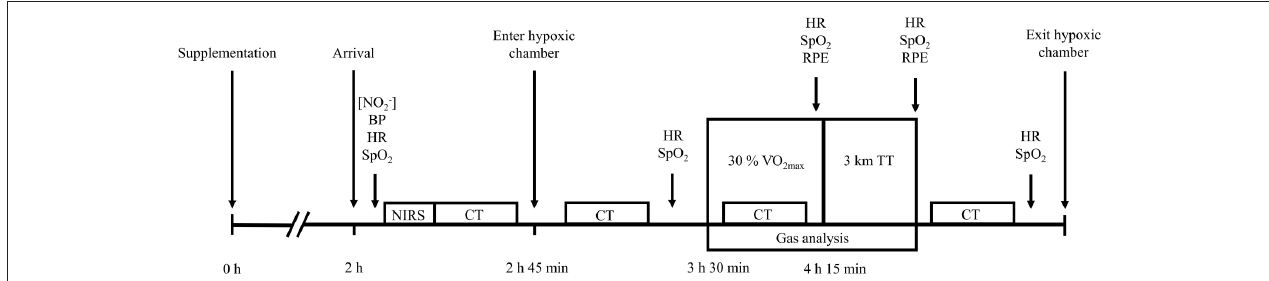
FIGURE 1 | A schematic representation of the experimental trials protocol. [NO − 2 ], assessment of plasma nitrite concentration; BP, blood pressure; HR, heart rate; SpO 2 , peripheral oxygen saturation; NIRS, near-infrared spectroscopy baseline; CT, cognitive testing; RPE, ratings of perceived exertion; TT,